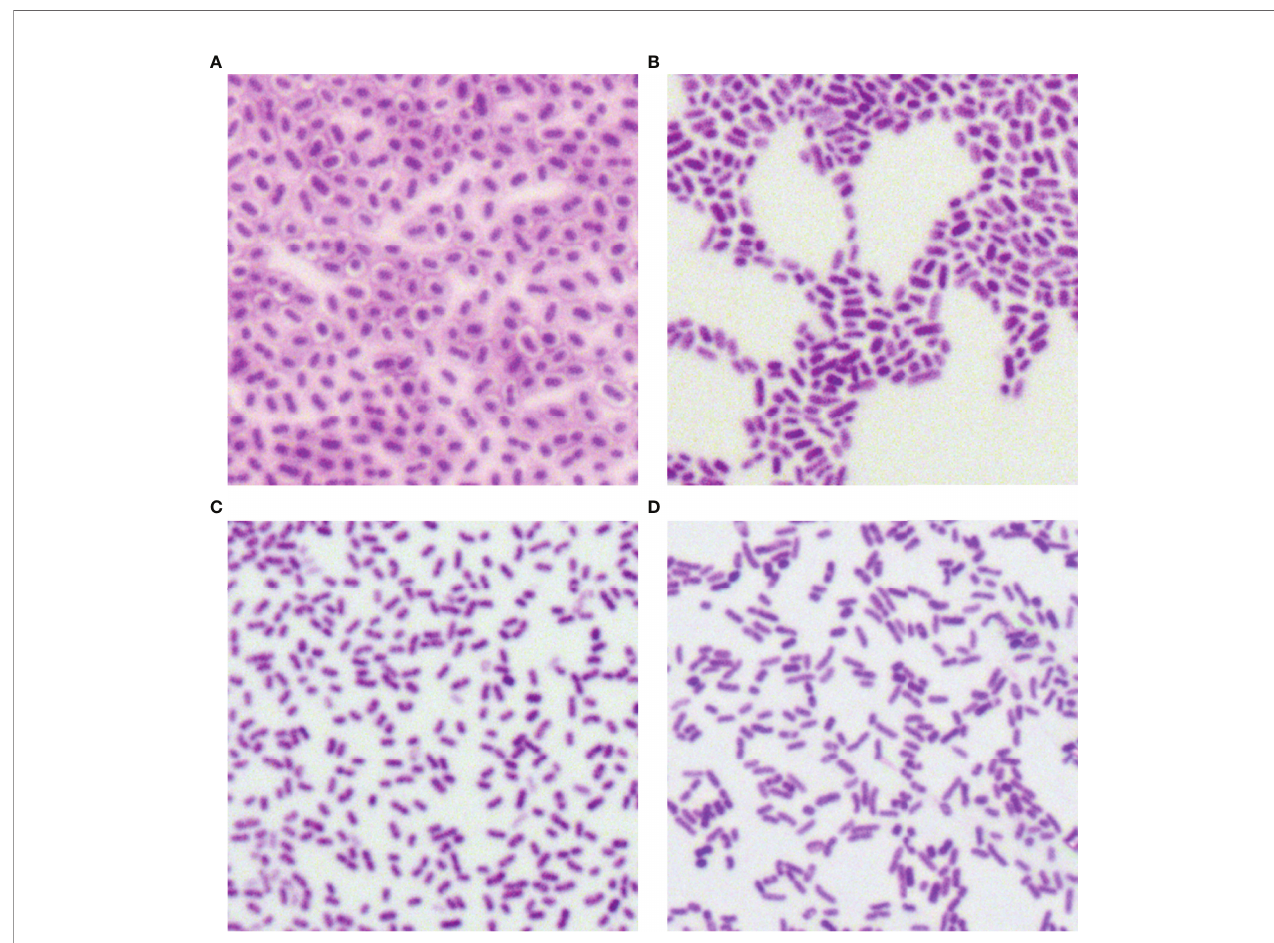
FIGURE 4 | Capsule staining of 35 putative bla KPC (+)-HvKP and Hv- bla KPC (+)-KP strains. (A) Klebsiella pneumoniae NTUH-K2044, (B) K. pneumoniae HS11286, (C) JS184, and (D) TZ20. K. pneumoniae strains are purple and rod-shaped, and their transparent surroundings are hypercapsules (×1000). bla KPC , beta-lactamase K. pneumoniae carbapenemase gene; bla KPC (+)-HvKP, bla KPC (+) hypervirulent K. pneumoniae ; Hv- bla KPC (+)-KP, hypervirulent bla KPC (+) K. pneumoniae